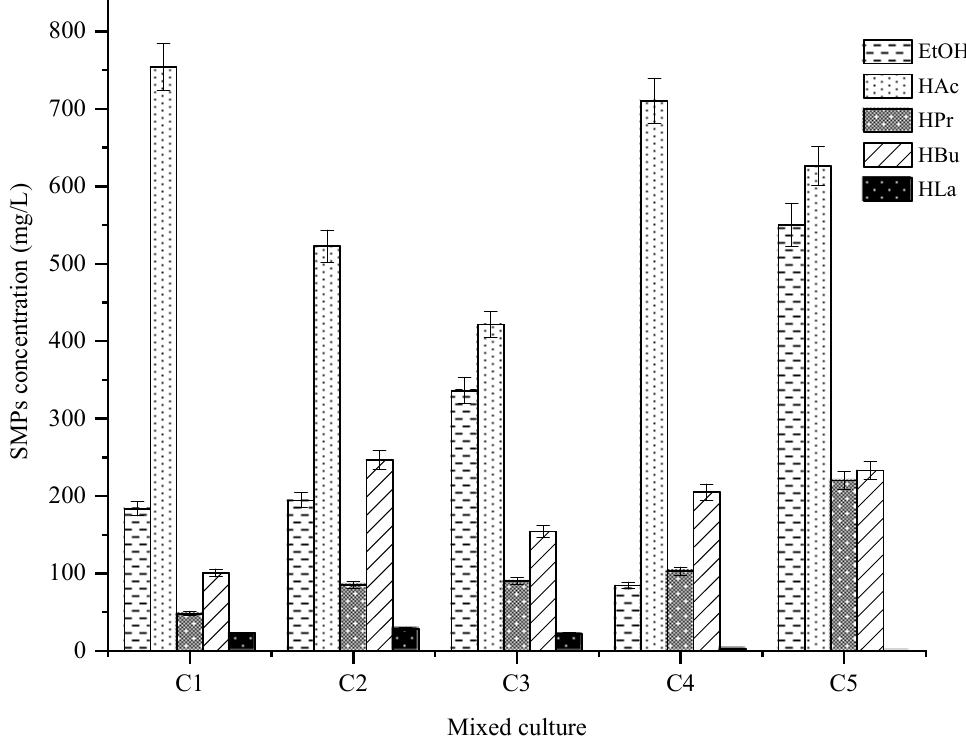
Figure 2. Soluble metabolite product (SMP) in each repetitive sub-culture for five generations (Cycle (C) 1–Cycle (C)